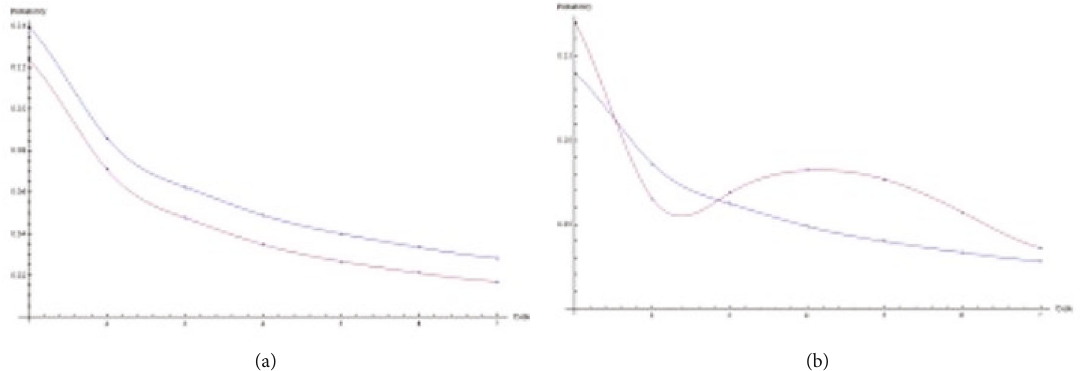
Figure 7: Mixture distributions for (a) resembling images and (b) unlike